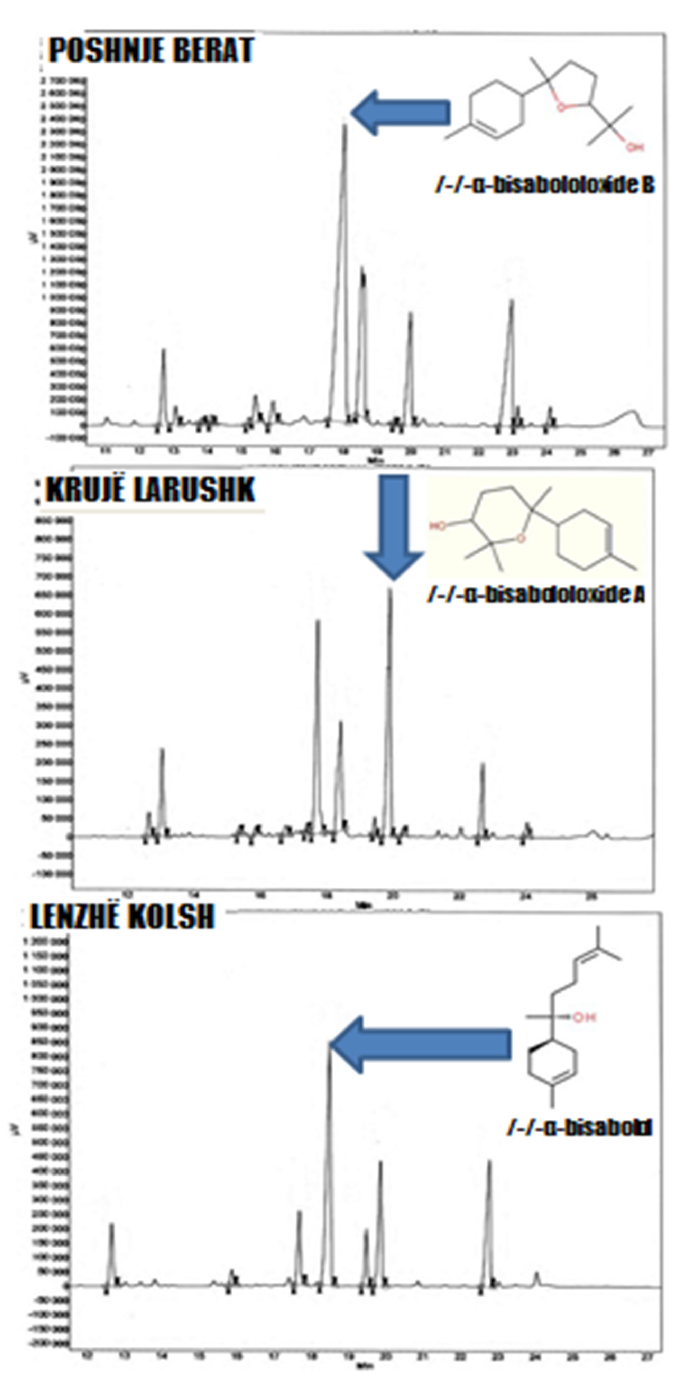
Figure 2. The differences in the chromatographic profiles of chamomile essential oil from three Albanian localities: Poshnje Berat, Krujë Larushk and Lezh ȅ Kolsh.